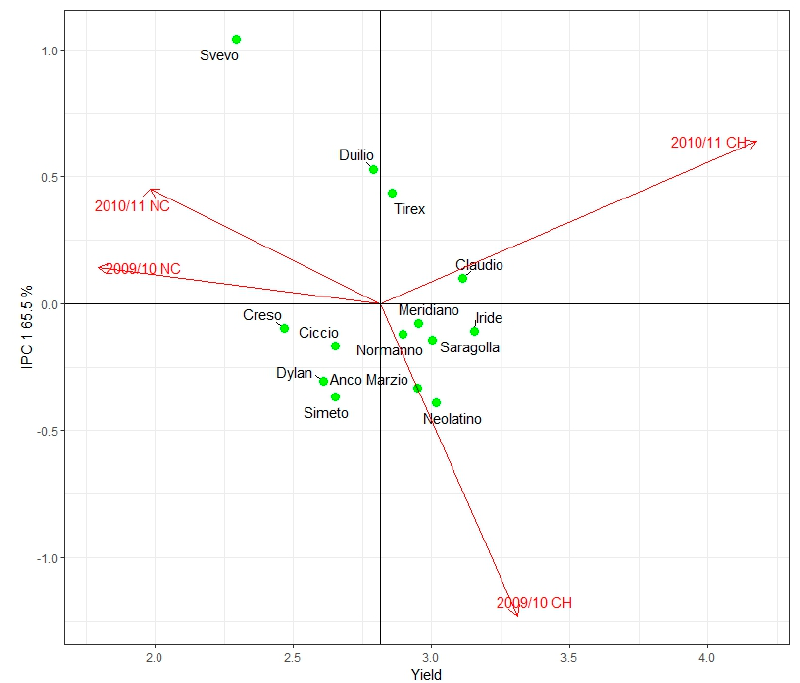
Figure 5. Grain yield versus interaction principal component axes (IPCA)1 of fourteen durum wheat genotypes under CH and NC in 2009/10 and in 2010/11 growing seasons.